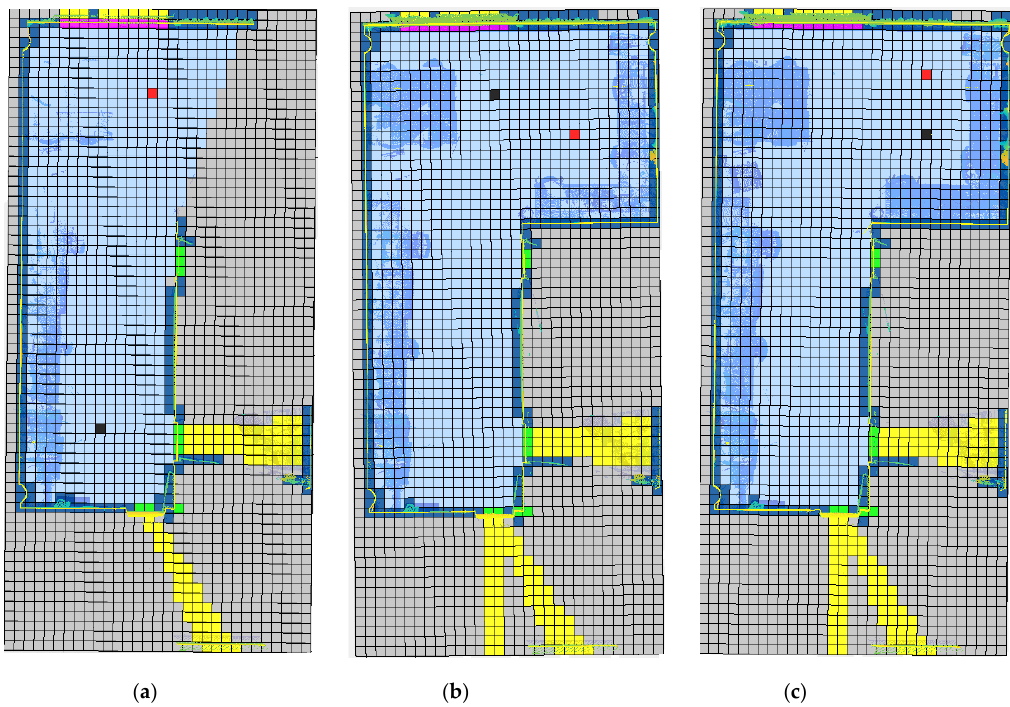
Figure 18. Horizontal plane of voxels for each scan. Dark blue: occupied; light blue: empty; green: door; magenta: window; grey: occluded; yellow: out; black: scanner position; red: NBV. ( a ) First scan. ( b ) Second scan. ( c ) Third scan.